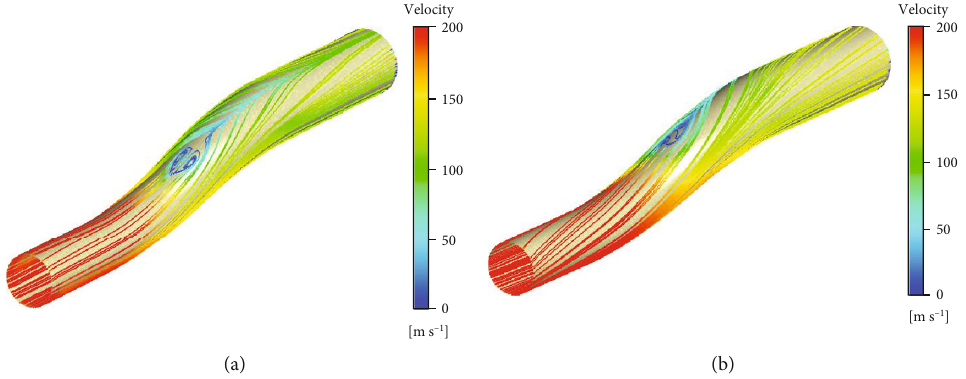
Figure 5: The surface limit pathline for the S-shaped intake with/without propeller.